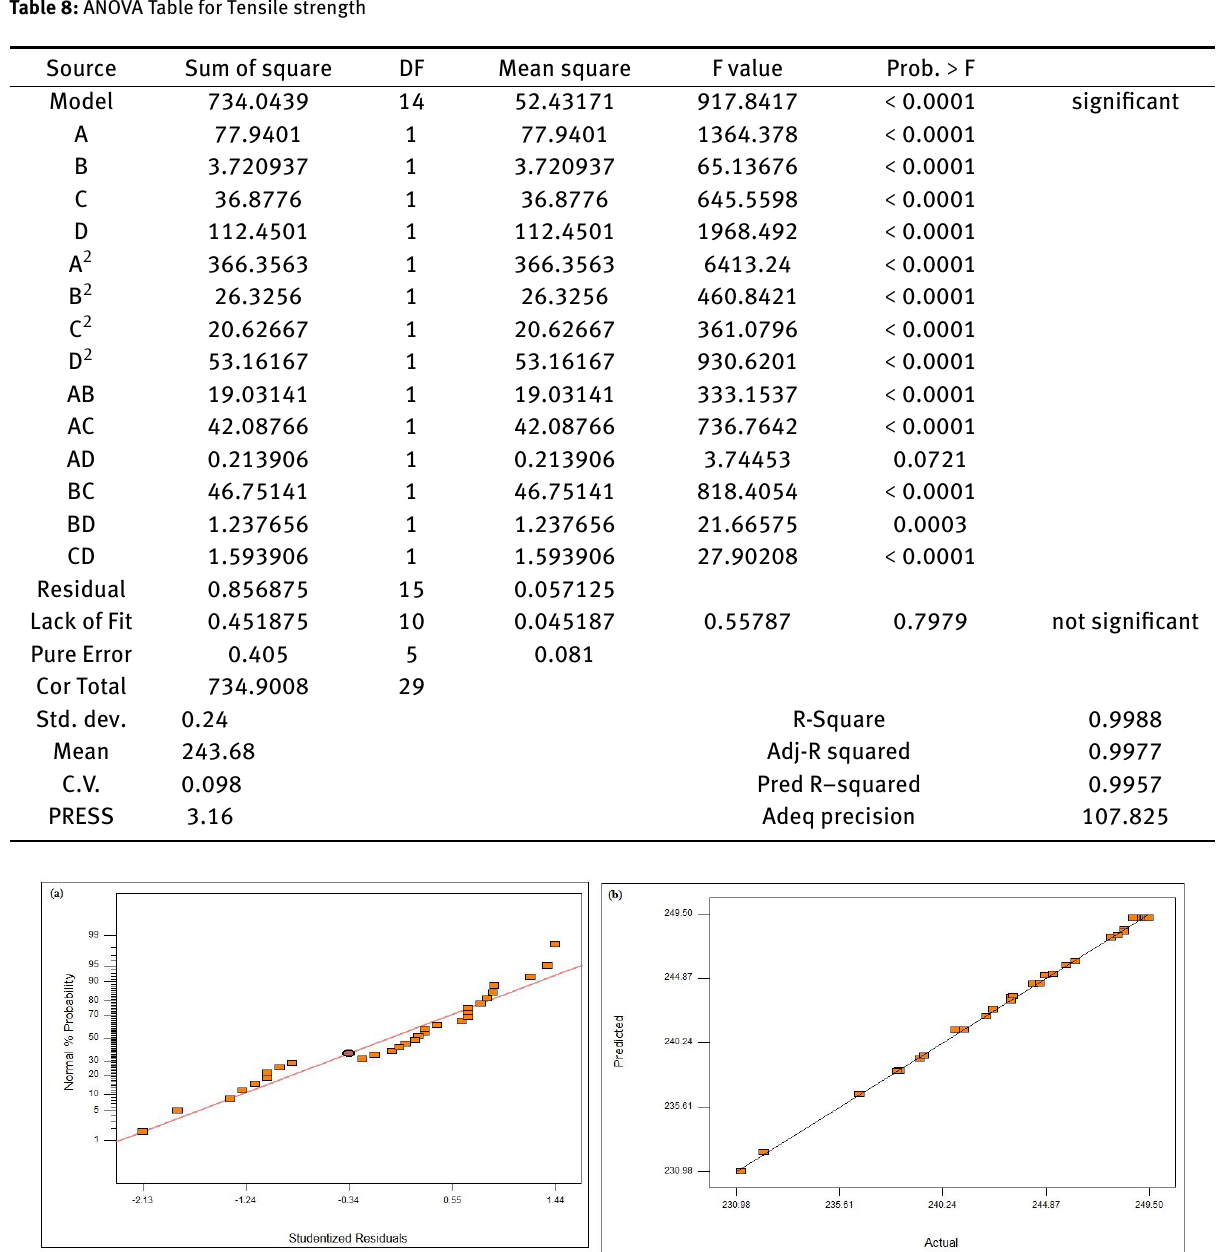
Figure 6: (a) Normal % probability graph, (b) predicted v/s actual